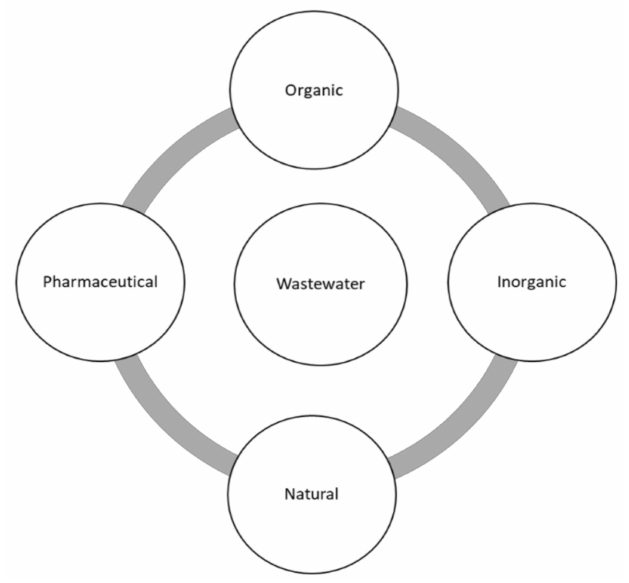
Figure 2. Schematic illustration of various pollutants in wastewater